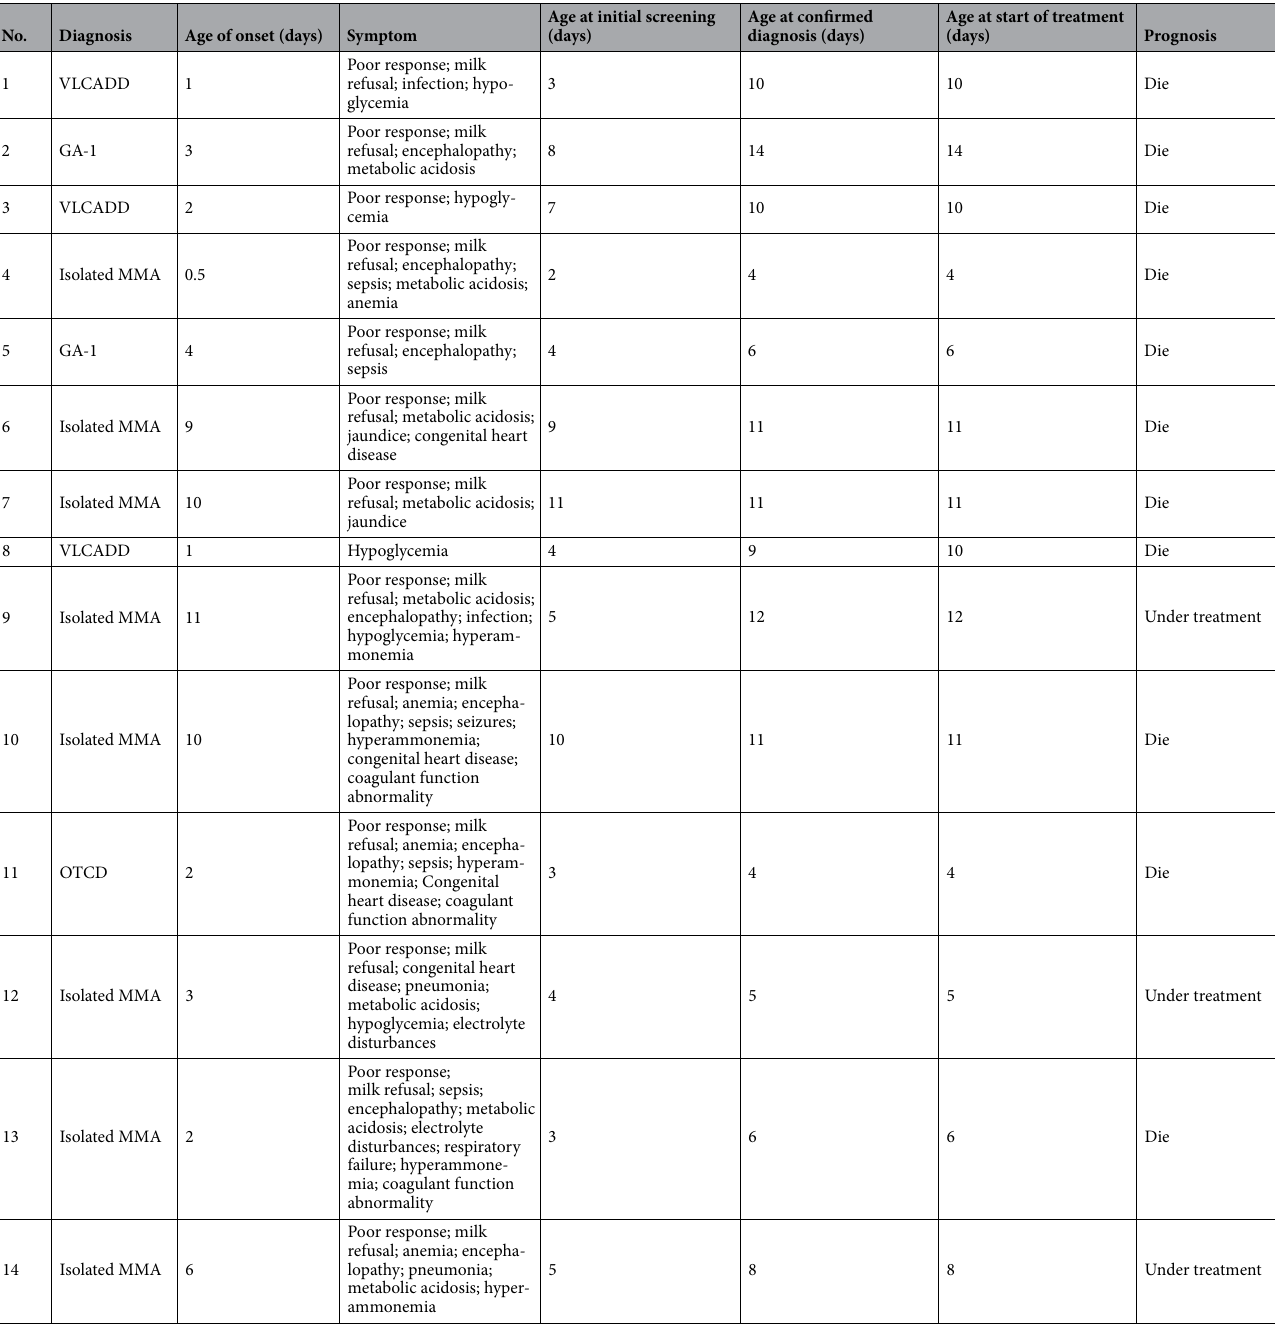
Table 5. Details of patients who became symptomatic before establishing the